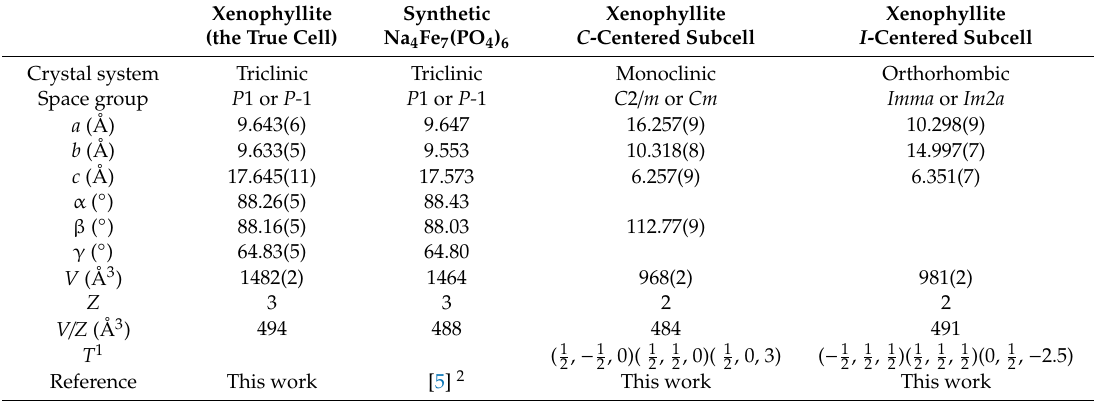
Table 4. The relationships between true triclinic cell of xenophyllite, the unit cell of its synthetic analogue and two xenophyllite subcells. Xenophyllite Synthetic Xenophyllite Xenophyllite C -Centered Subcell I -Centered Subcell (the True Cell) Na 4 Fe 7 (PO 4 ) 6 Crystal system Triclinic Triclinic Monoclinic